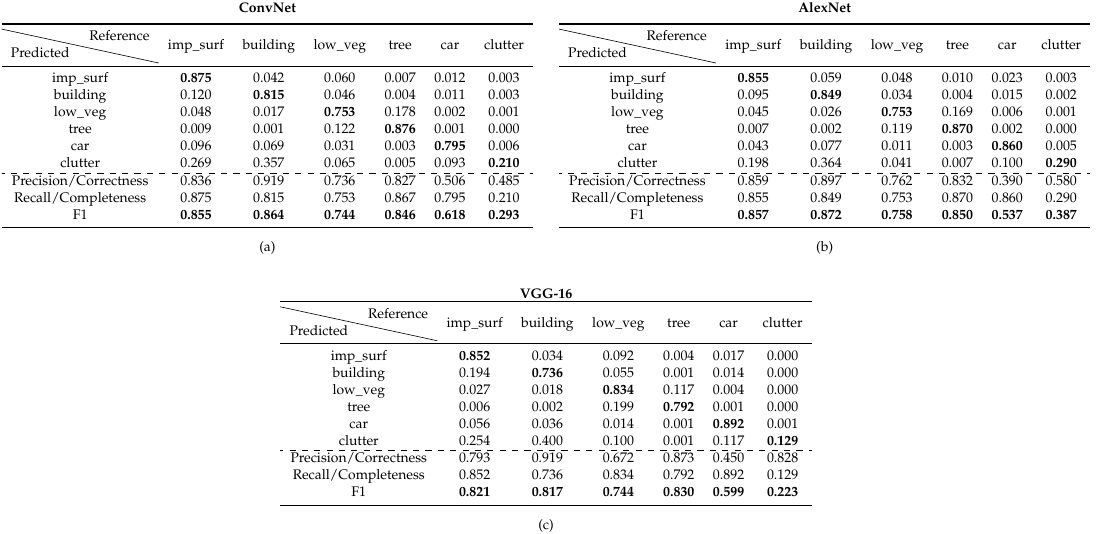
Figure 4. Resulting Confusion Matrices for ConvNet, AlexNet and VGG-16 frameworks on the Vaihingen